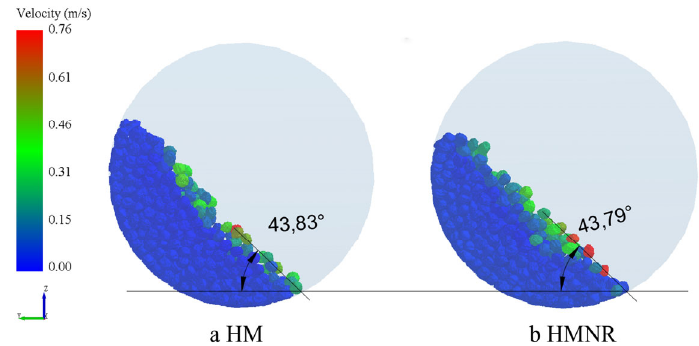
Figure 24. Snapshots of the simulation for the rotating hub test with the different contact models.